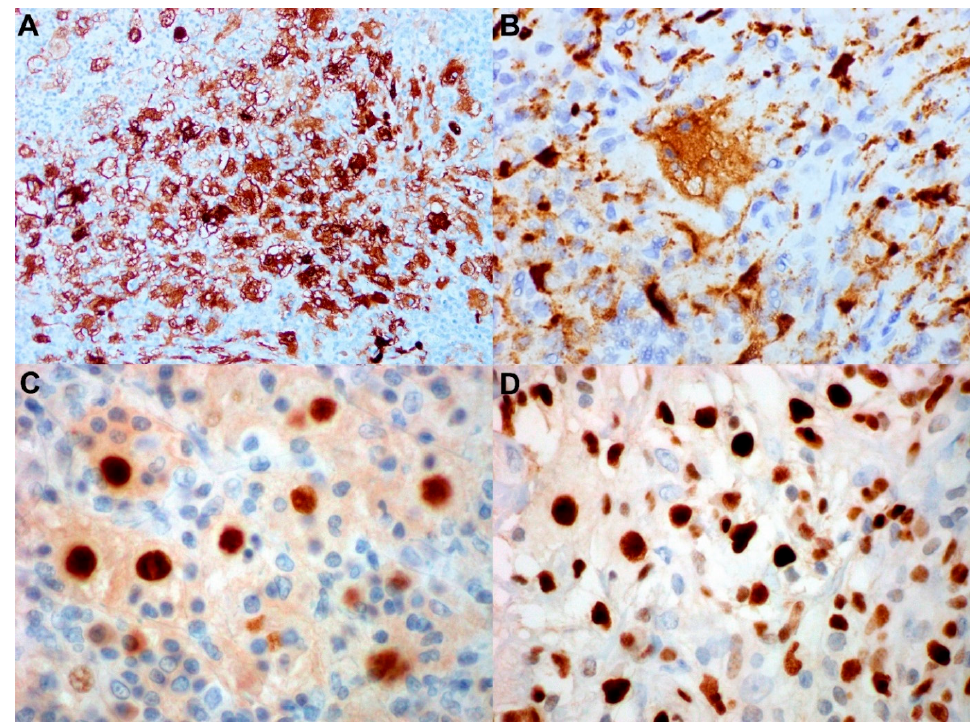
Figure 2. Routine immunohistochemical stains for Rosai–Dorfman disease. ( A ) S ‐ 100 immunohisto ‐ chemical stain highlighting the histiocytes, which also demonstrates emperipolesis (immunoperox ‐ idase, magnification 600×). ( B ) CD68 immunohistochemical stain highlighting the histiocytes (im ‐ munoperoxidase, magnification 600×). ( C , D ) BCL ‐ 1 and Oct2 immunohistochemical stains are pos